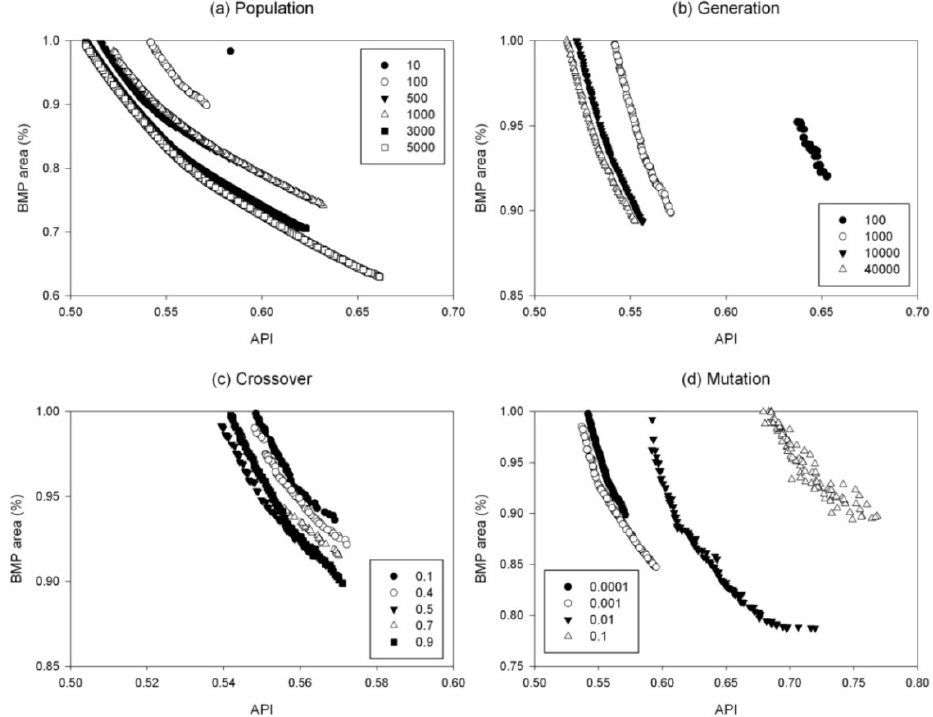
Figure 4. Pareto-optimal fronts for the sensitivity analysis of genetic algorithm (GA) parameters for the optimization model with a set of VFS42 BMP